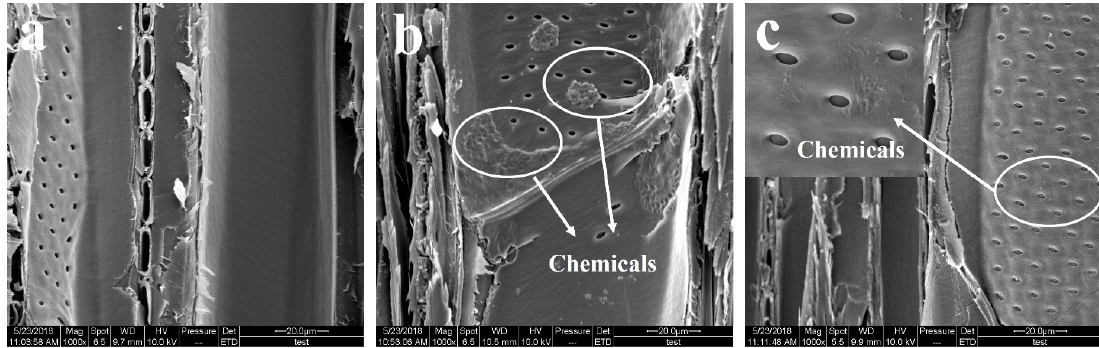
Figure 10. Micrographs of the tangential sections of T1 ( a ), T2 ( b ), and T3 ( c ) after drying.